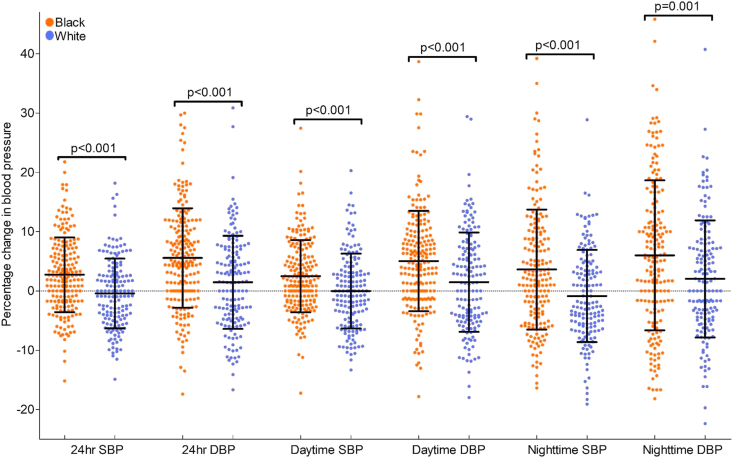
Percentage change in ambulatory blood pressure over 4.5 years in young black and white adults. Horizontal line and whiskers: Mean ± SD. Abbreviations: SBP Systolic blood pressure; DBP Diastolic blood pressure.